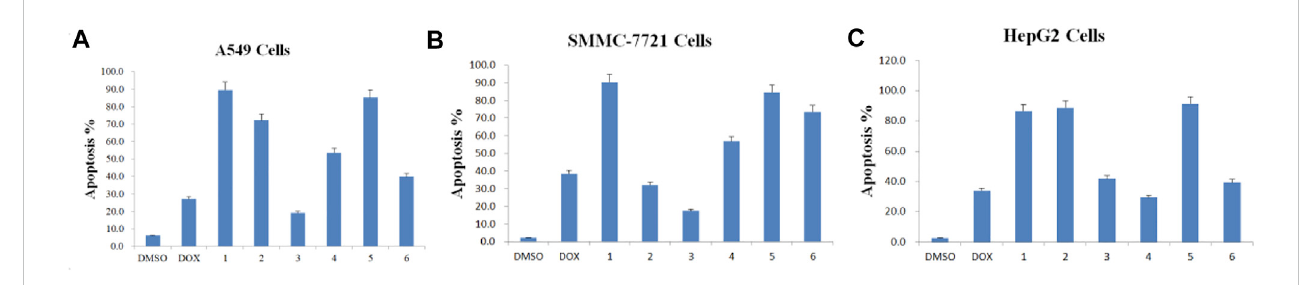
FIGURE 7 Apoptosis rate induced by each of the six puri fi ed saponins in three cancer cell lines (A549, SMMC-7721 and